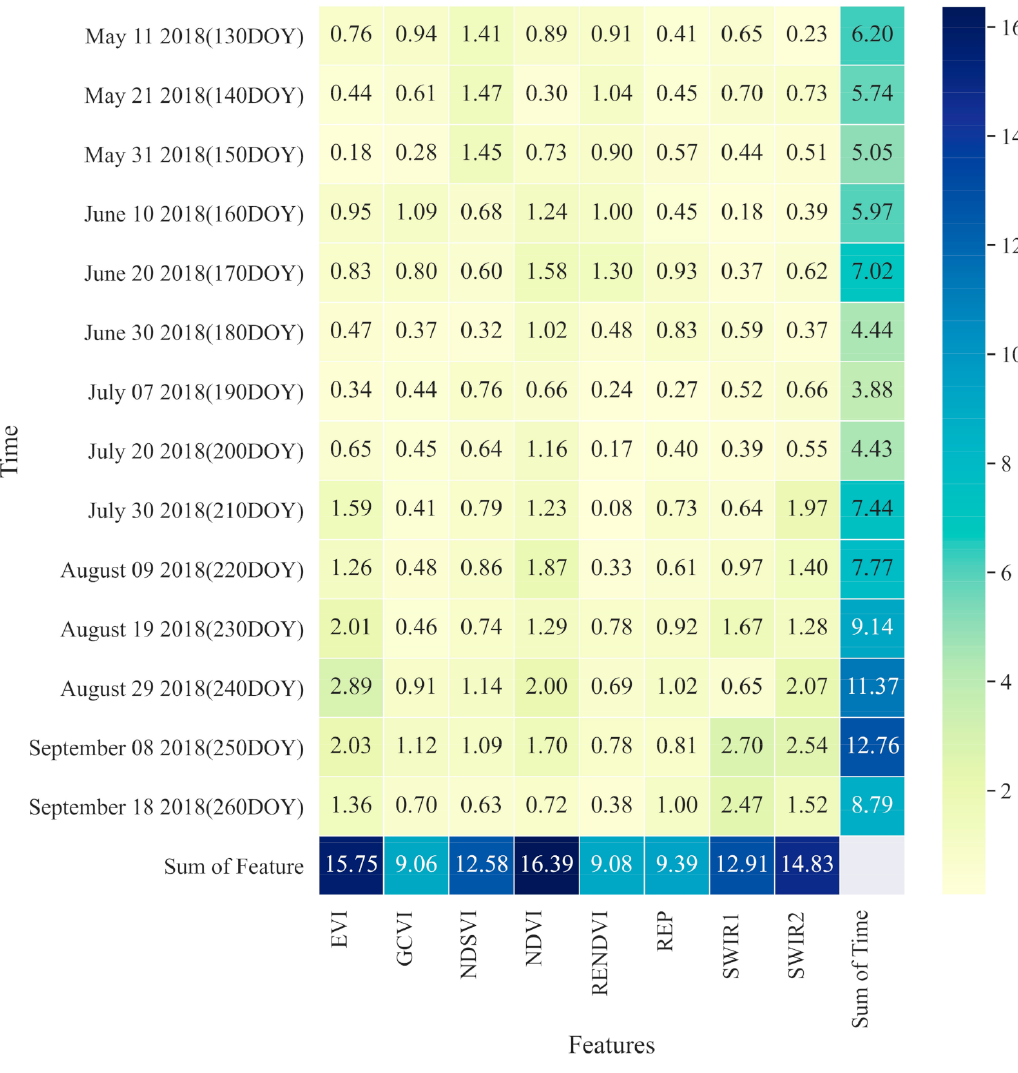
Figure 9. Contribution of metrics to crop-type